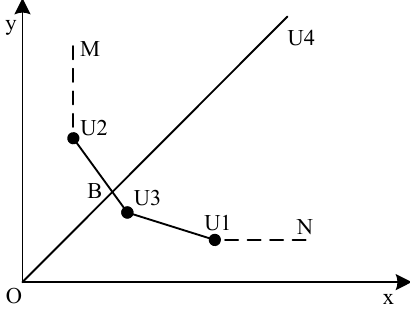
Figure 3. DEA efficiency evaluation principle.